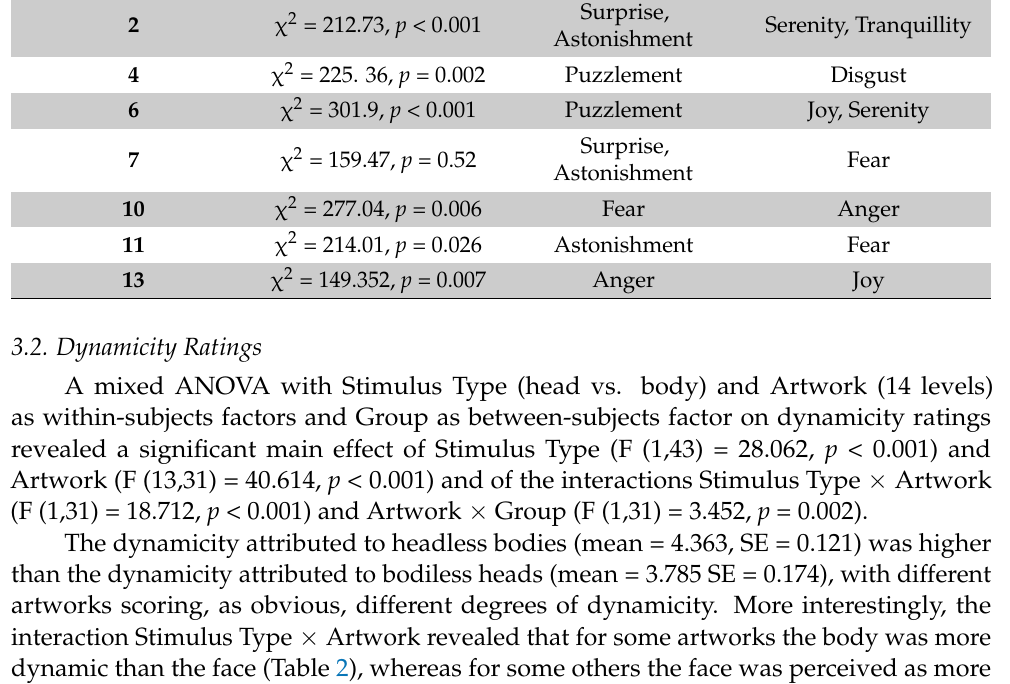
Table 1. Different emotions identified for face and body of the same static artwork. S TIMULI